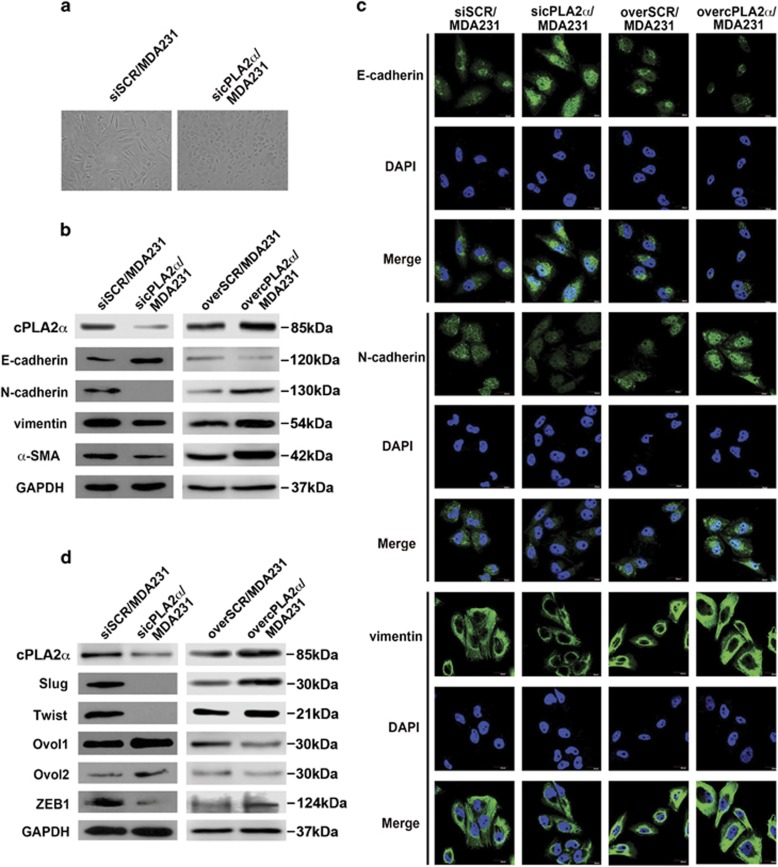
The depression of cPLA2α inhibited TGF-β-induced EMT and promoted MDA-MB-231 cells occurring MET. (a) Morphologic change of the MDA-MB-231 cells when cPLA2α was endogenously knocked down. (b) Western blot of the expression of EMT-associated markers (epithelial marker E-cadherin, mesenchymal markers N-cadherin, vimentin and α-SMA) in MDA-MB-231 cells when cPLA2α was knocked down or overexpressed, respectively. (c) Immunofluorescence staining for EMT-associated markers (epithelial marker E-cadherin, mesenchymal markers N-cadherin, vimentin) in SCR/MDA-MB-231, sicPLA2α/MDA-MB-231 and ovecPLA2α/MDA-MB-231 cells, respectively. Scale bar, 20 μm. All experiments were repeated at least three times. (d) Compared EMT-associated transcription factors (Slug, Twist and ZEB1) and MET-associated transcription factors (OVOL1 and OVOL2) expression between siSCR/MDA-MB-231 and sicPLA2α/MDA-MB-231 cells (left); overSCR/MDA-MB-231 and overcPLA2α/MDA-MB-231 cells (right) by western blot assay, respectively. Scale bar, 20 μm